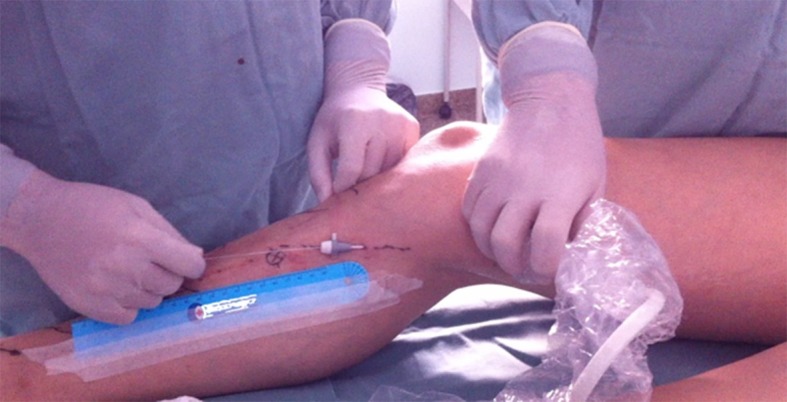
Puncture site and monitoring of progress of fiber with ultrasound.